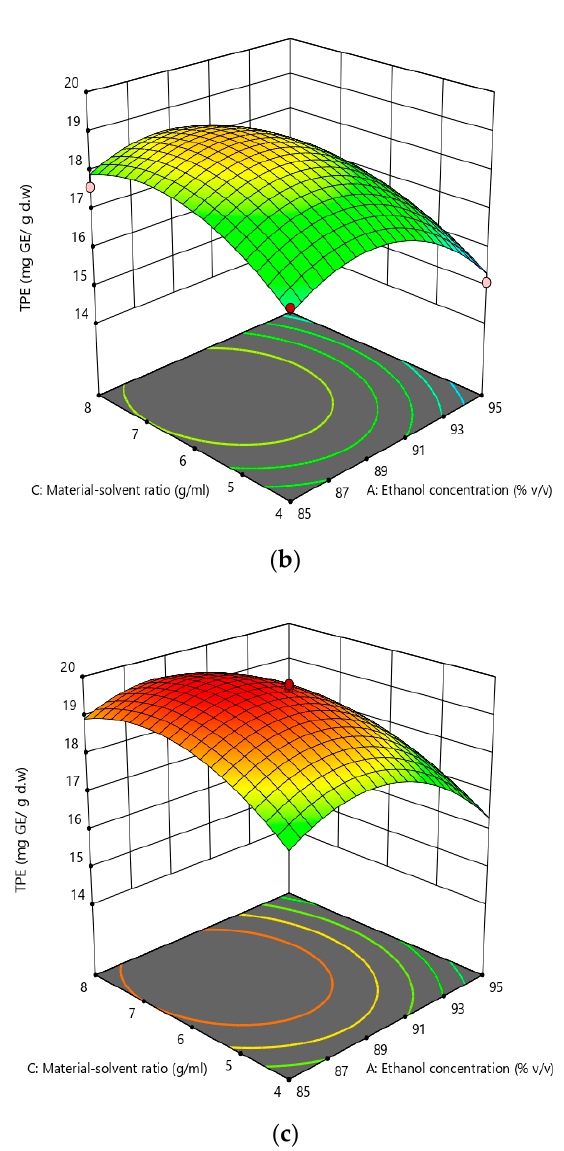
Figure 10. Response surface plot showing effects of material:solvent ratio and ethanol concentration on yield of TPC. ( a ) Extraction temperature of 55 °C; ( b ) Extraction temperature of 60 °C; ( c ) Extraction temperature of 65 °C.